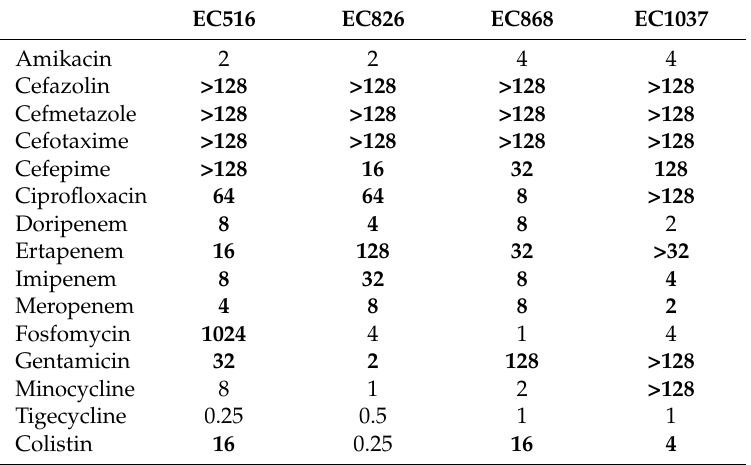
Table 2. MIC results of mcr-1 -positive carbapenem-resistant E. coli